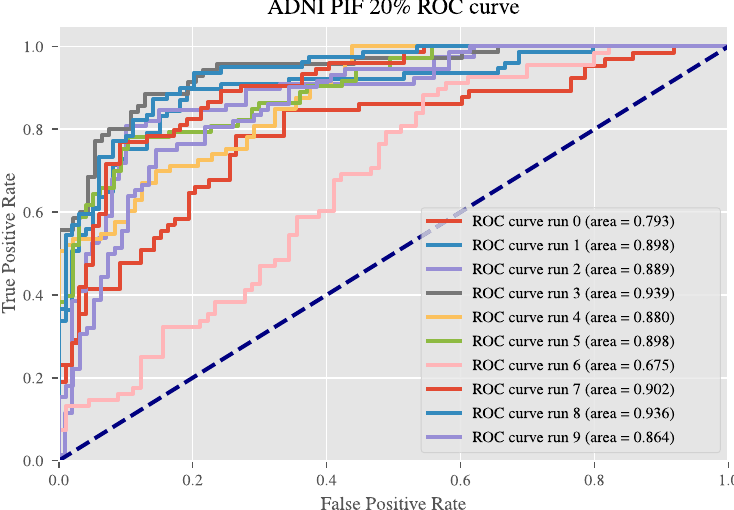
Figure 7. Receiver operating characteristic (ROC) curves for all 10 runs of the PIF model trained on the 20% ADNI data set.